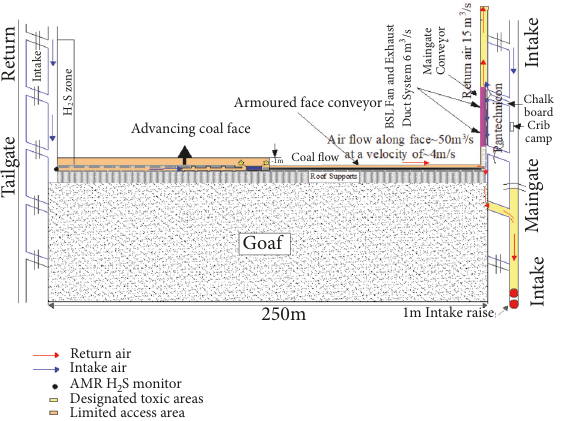
Figure 12: Alternative full homotropal